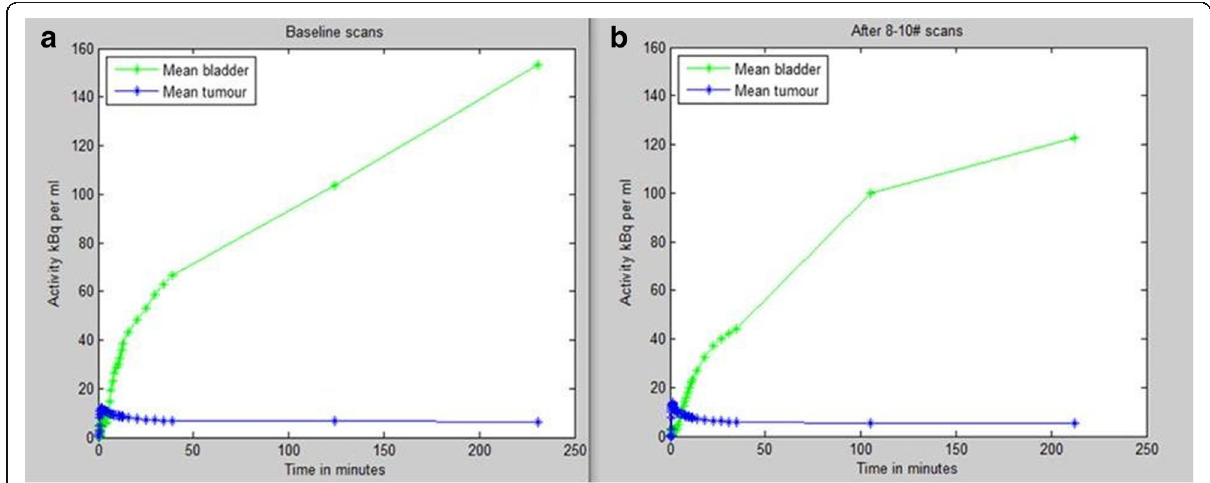
Fig. 3 The [ 18 F]FMISO PET mean time activity curve of bladder and tumour at baseline in a and after 8 – 10 fraction of radiotherapy in b over 0-4 h. [ 18 F]FMISO = [ 18 F]fluoromisonidazole; h = hour; PET = positron emission tomography; kBq = kilo Becquerel; ml = millilitre; 1 millilitre = 1 cm